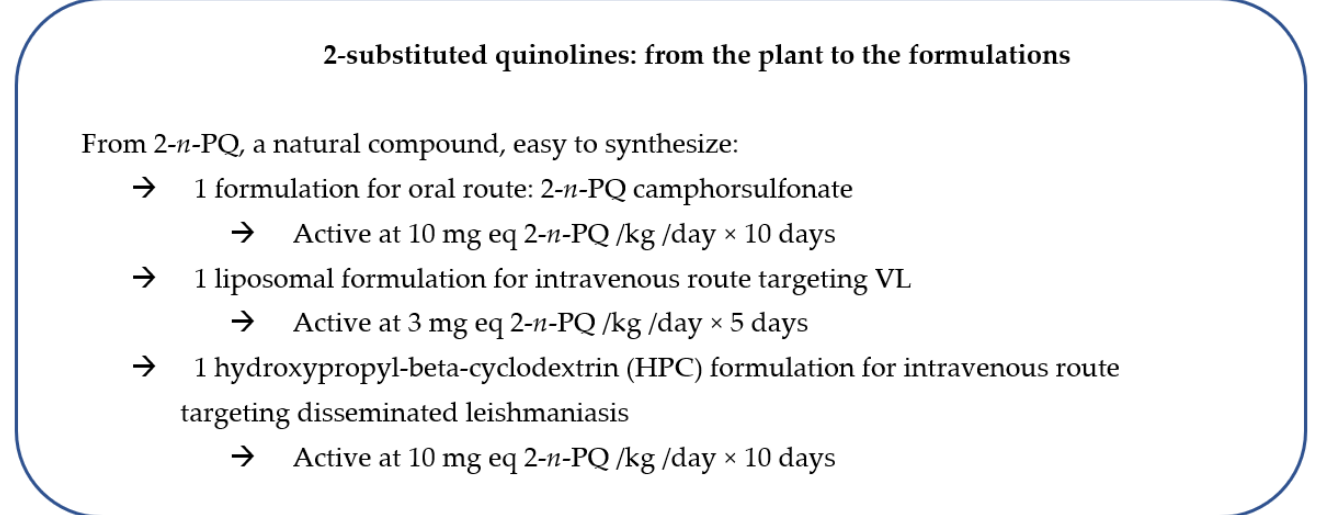
Figure 4. Formulations of 2 -n- propylquinoline that merit further investigation.